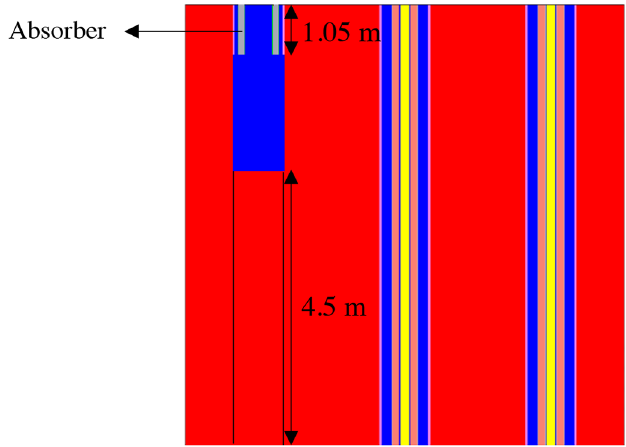
Fig. 8. Control rods are initially inserted without poisoning.